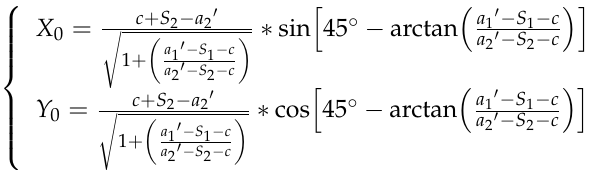
where a 1 (cid:48) and a 2 (cid:48) are the test values of sensors #1 and #2 at the reference point, S 1 and S 2 are the distance between the two sensor probes and the bearing inner surface, c is the radius clearance, e (cid:48) is the eccentricity distance of the reference point, and θ 0 (cid:48) is the eccentricity angle of the reference point. The equation is solved to obtain the absolute coordinate values X 0 and Y 0 of the reference point in a right-angle coordinate system.